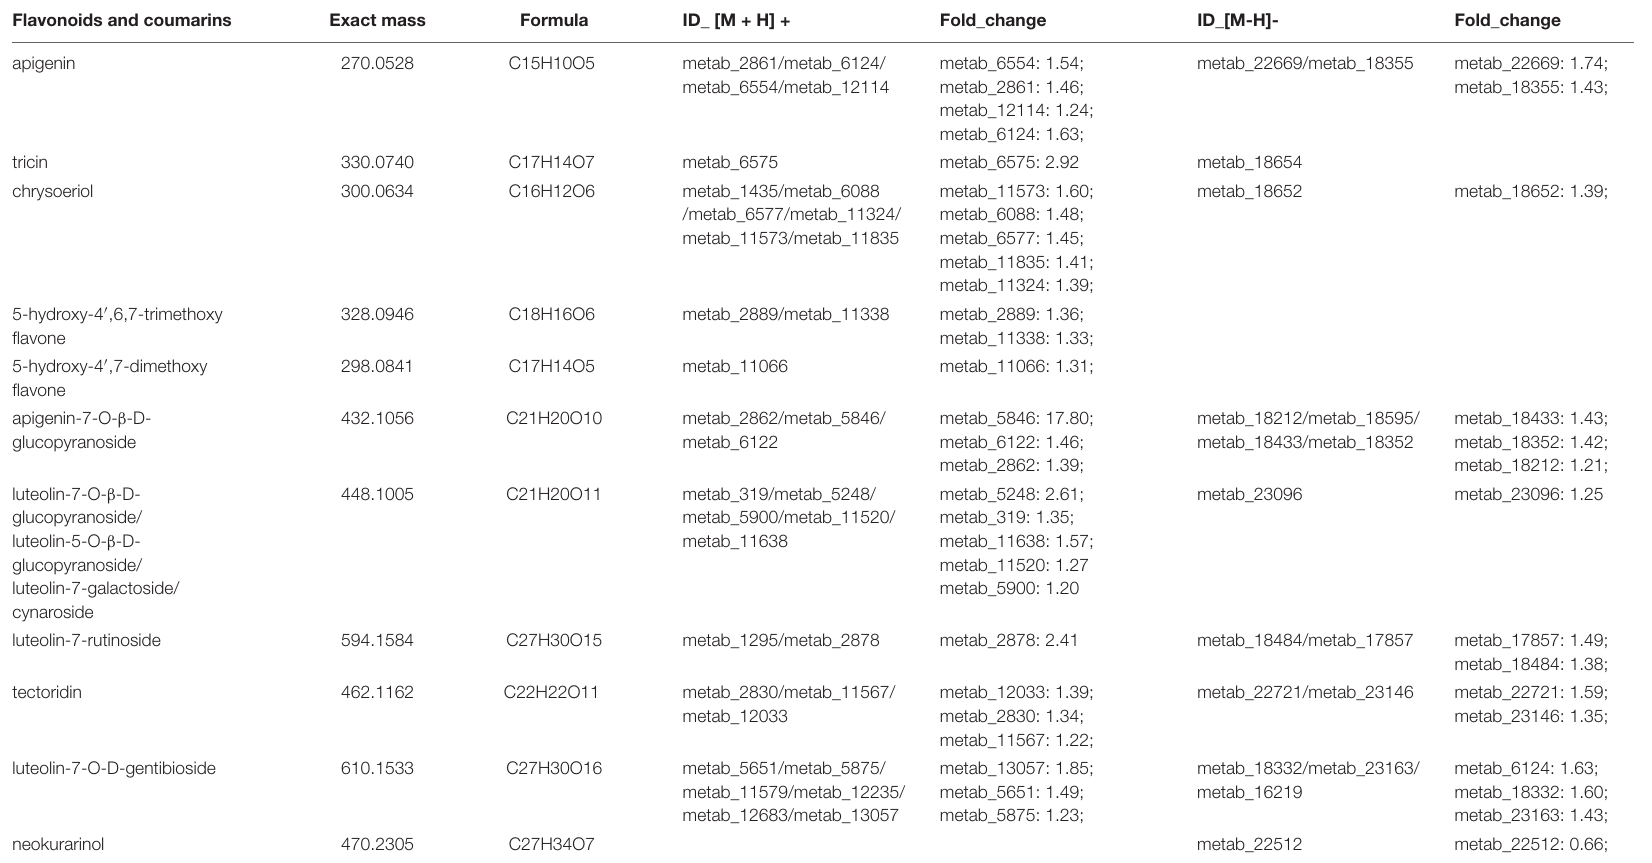
TABLE 2 | Differentially expressed metabolites (DEMs) annotated as flavonoids and coumarins. Flavonoids and